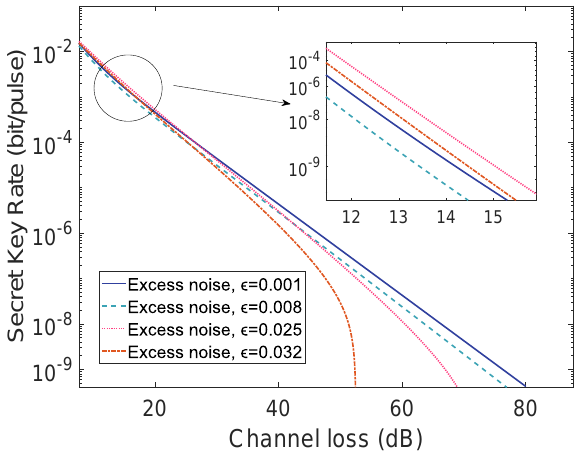
Figure 5. The relationship between the secret key rate of the system and different values of the excess noise (cid:101) under the one-photon subtraction operation of the eight-state